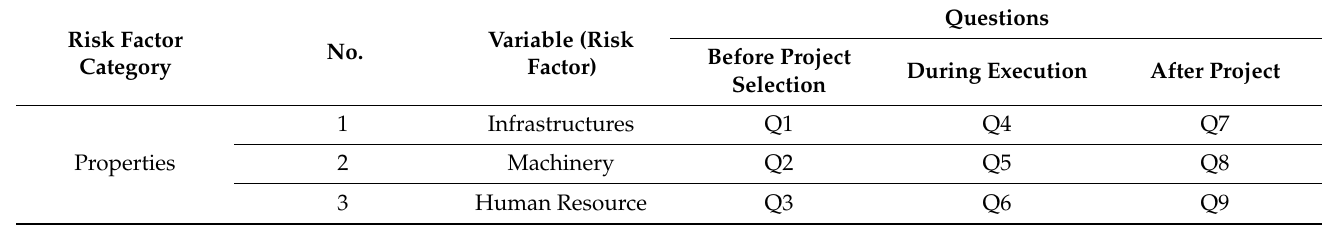
Table 1. Risk factor categories and related independent